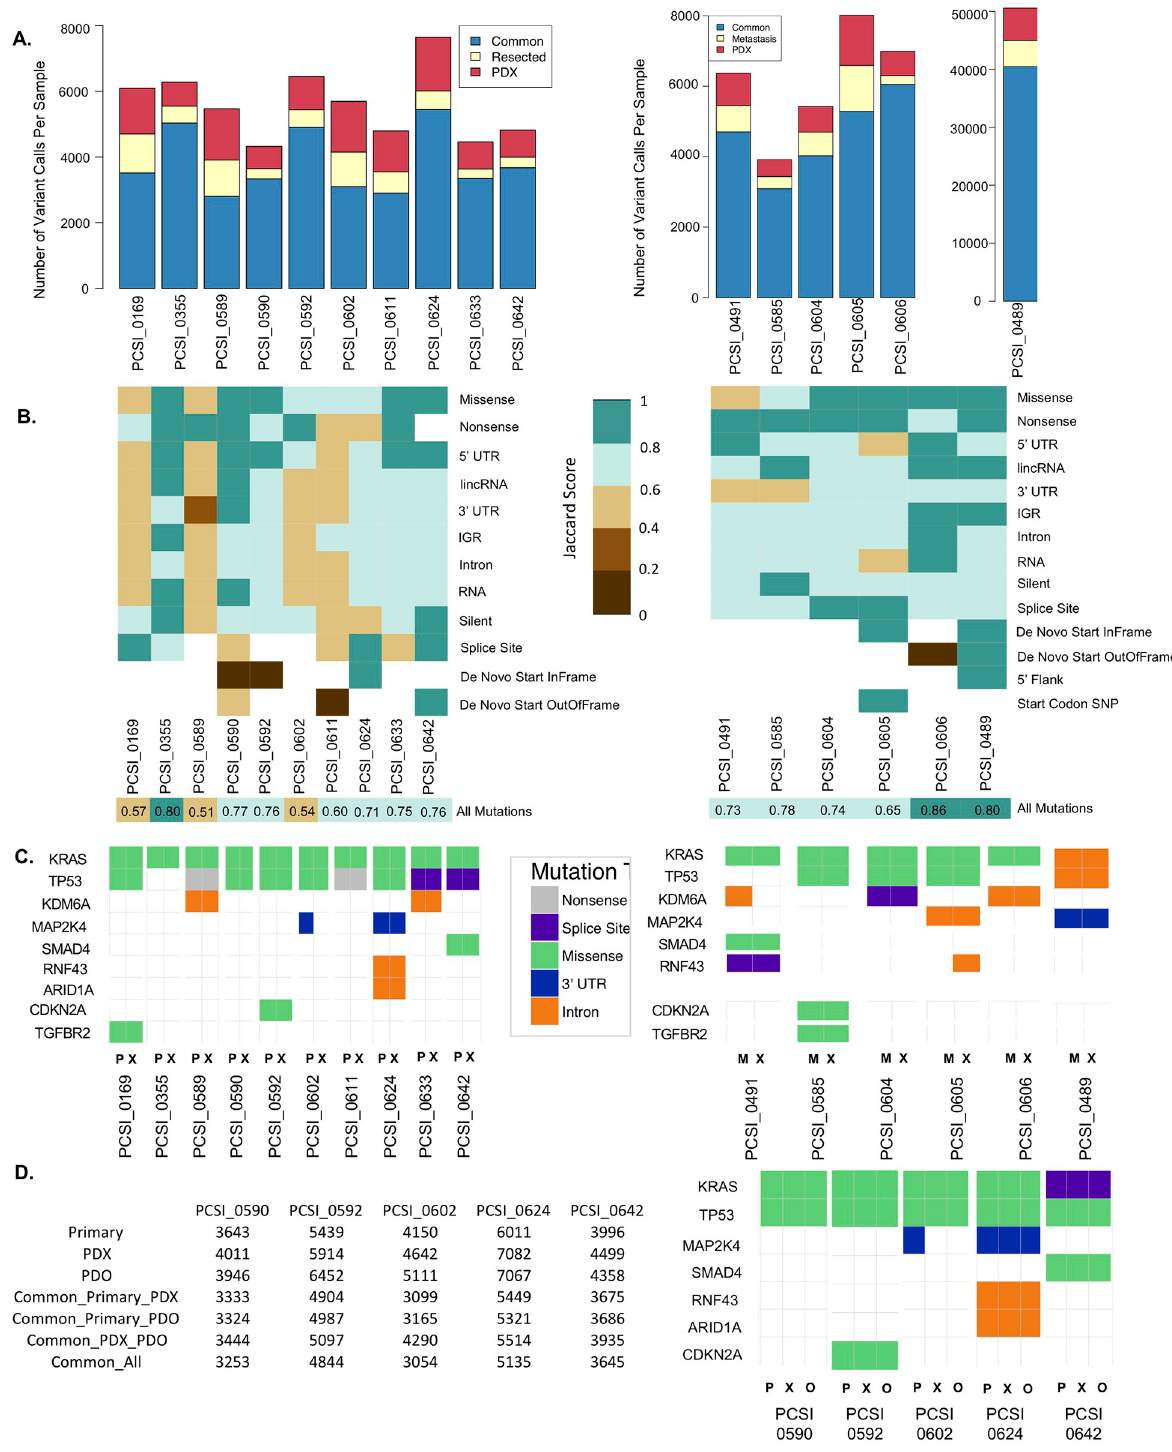
Fig 4. Comparative analysis of SSM across tumour-PDX pairs of resected primary (left) and liver metastasis (right). (A) Total number of variant calls across matched tumour-PDX pairs for 10 primary samples (left) and 6 metastasis samples (right). The total number of common mutations across a given pair is indicated, as well as variants that are specific to the tumour sample or matching PDX. (B) Heatmap representation of the Jaccard index for a given tumour-PDX pair, across all categories of functional and non-functional mutation types annotated in the primary samples (left) and metastasis samples (right). White cells indicate mutation types that are not available for a tumour-PDX pair. Overall concordance